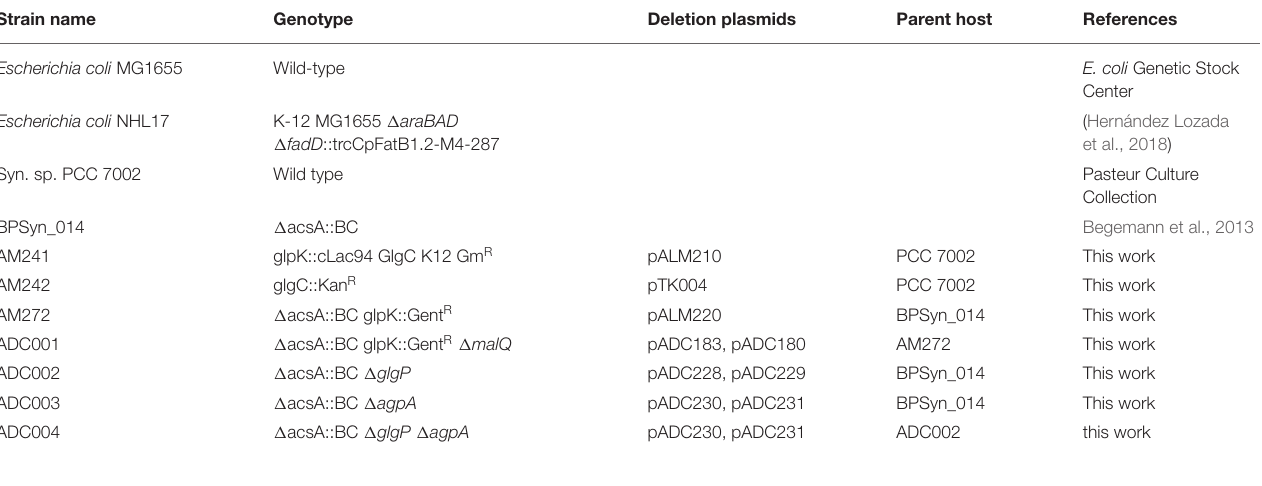
TABLE 1 | Strains used in this work.